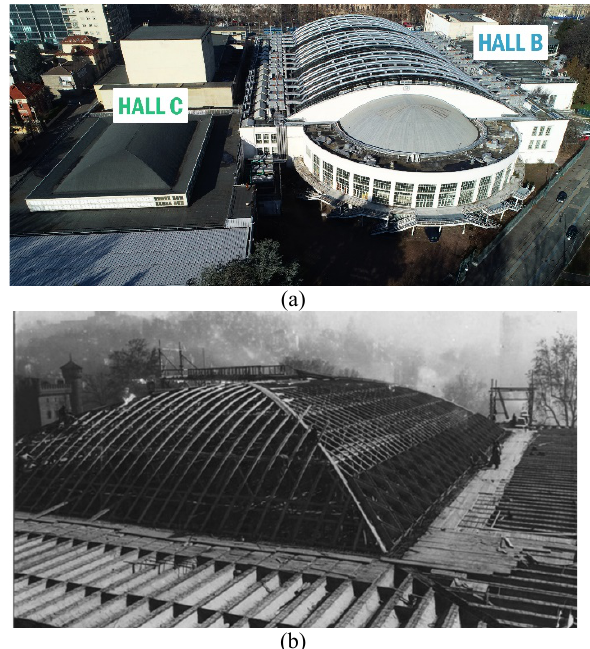
Figure 1. The Pier Luigi Nervi Halls in the Turin Exposition centre: (a) the two halls B and C from south-west UAV